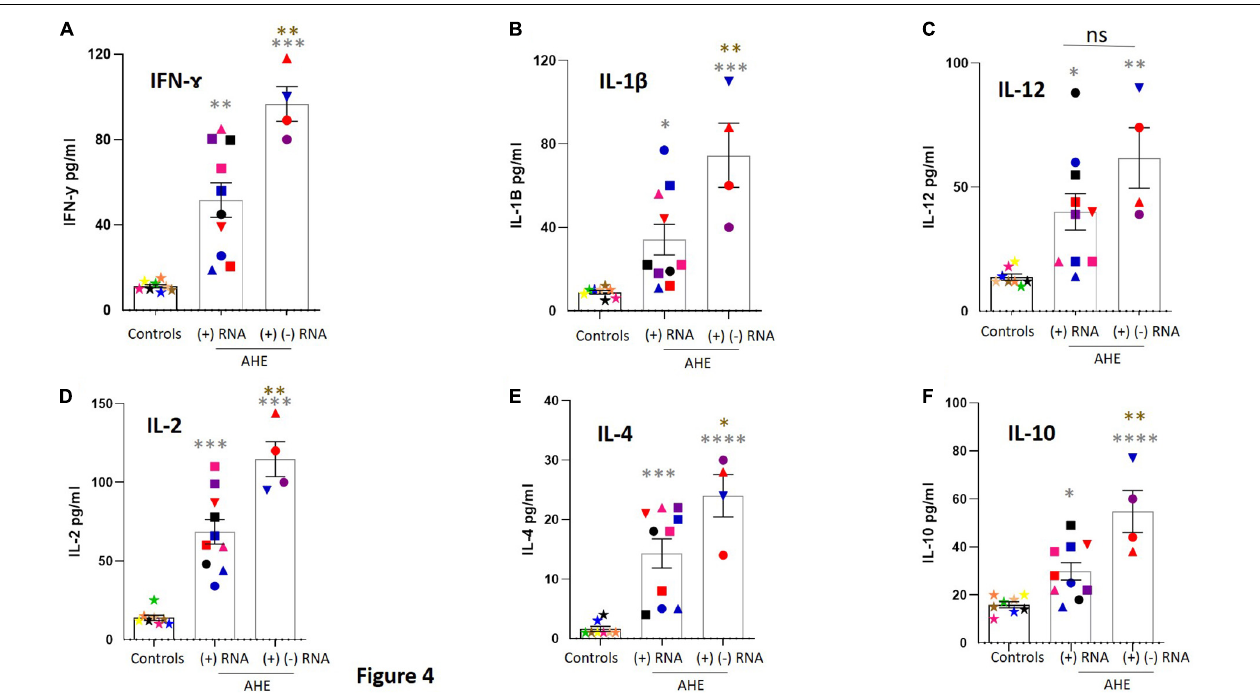
FIGURE 4 | Assessment of the level of cytokines in the plasma of AHE patients. (A–F) The level of cytokines, including IFN- G (A), IL-1 β (B) , IL-12 (C) , IL-2 (D) , IL4 (E) , and IL-10 (F) , was measured in the plasma of healthy controls ( n = 8), plasma of AHE patients who tested positive for the ( + ) RNA strand in the PBMCs ( n = 10), and plasma of AHE patients who tested positive for ( + ) and (–) RNA strands in the PBMCs ( n = 4). Data represented as mean ± SEM. * (gray); compare AHE vs. healthy control, * (brown): compare AHE patients with detectable ( + ) and (–) RNA strands in the PBMCs vs. AHE patients with detectable ( + ) RNA strand in the PBMCs. * , ** , *** , and **** means p < 0.05, 0.01, 0.001, and 0.0001, respectively, as determined by one-way ANOVA multiple comparison test.